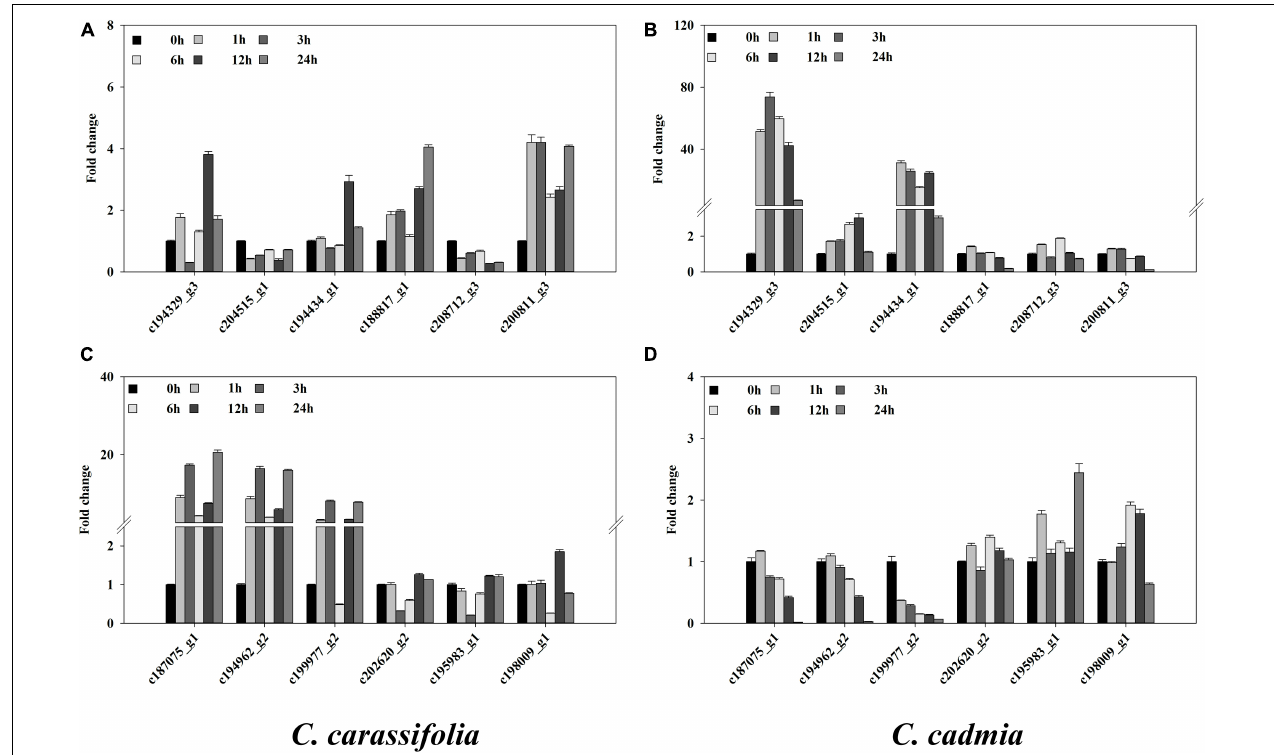
FIGURE 7 | Effect of heat stress on the gene expression in C. crassifolia and C. cadmia leaves. Time course of heat in C. crassifolia and C. cadmia shifted to 45 ◦ C. (A,C) C. carassifolia . (B,D) C. cadmia . Soluble protein content. Bars indicate SE ( n =